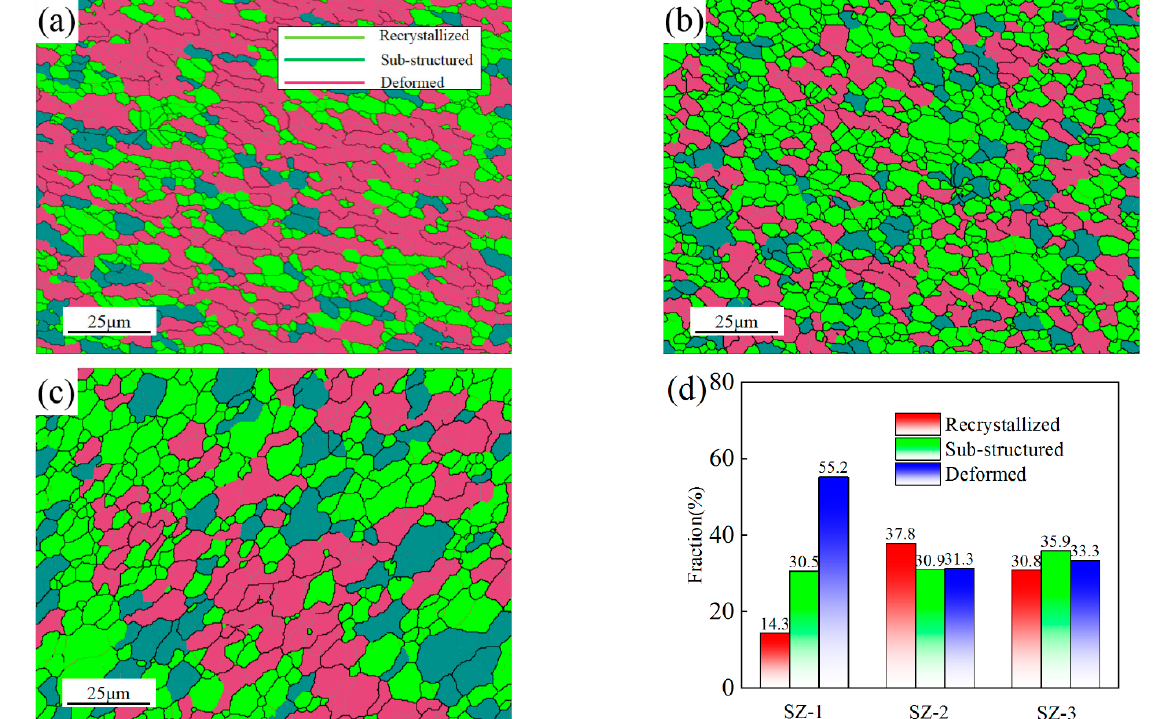
Figure 8. GOS maps of ( a ) SZ-1; ( b ) SZ-2; ( c ) SZ-3 and ( d ) Grain type